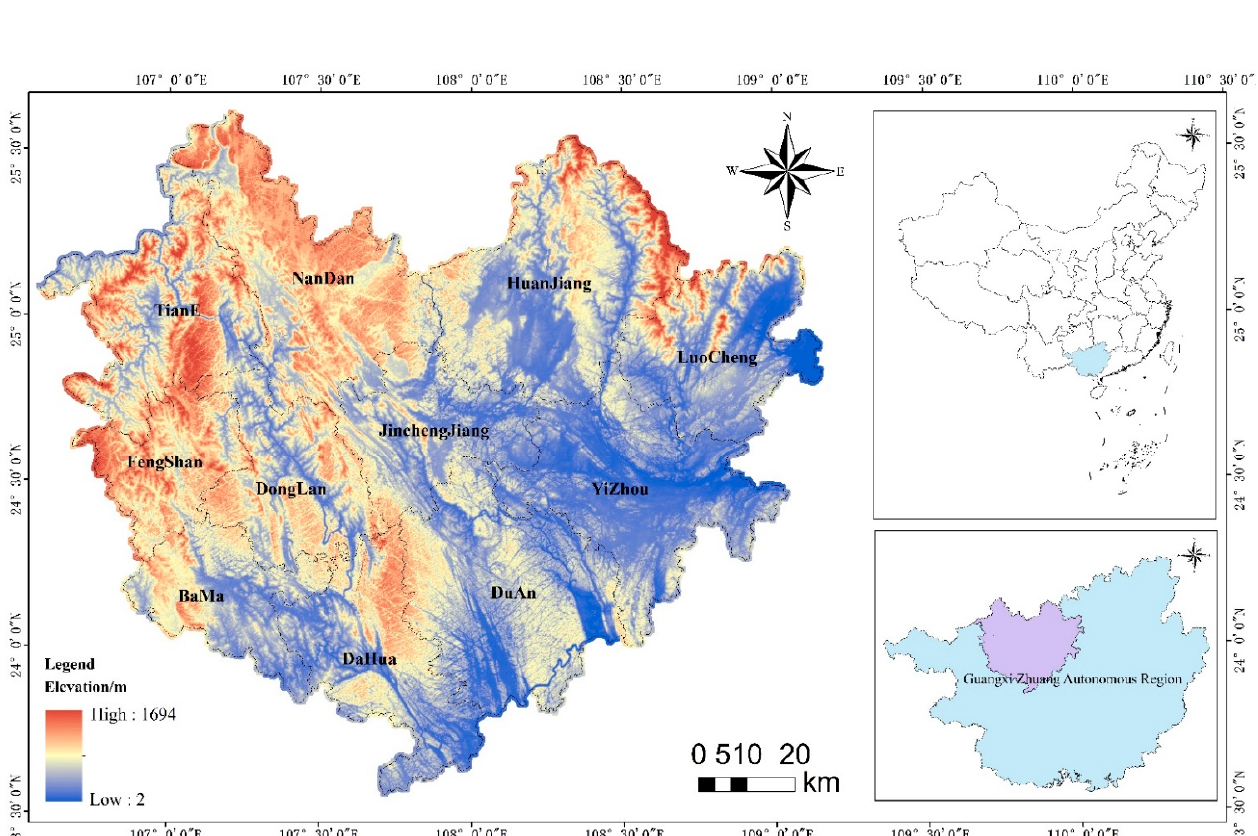
Figure 2. Location map of the study